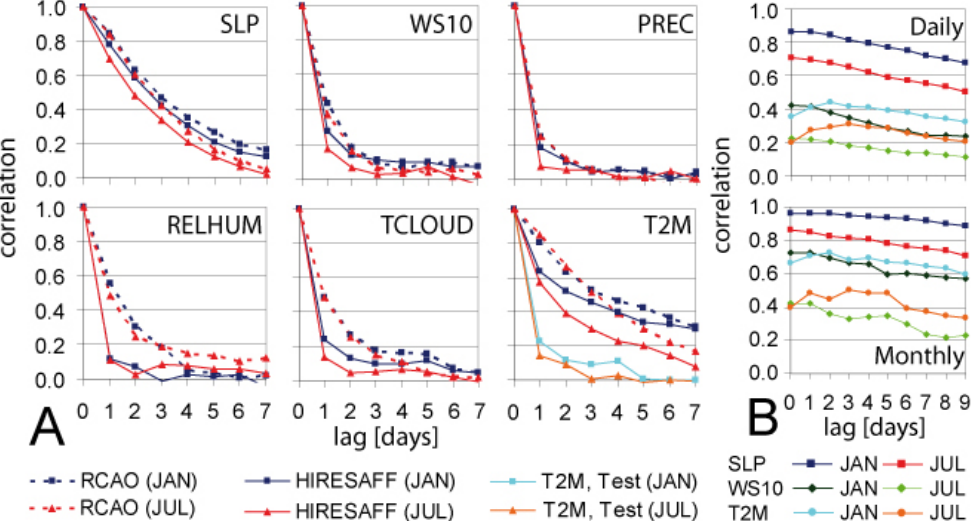
Fig. 10. Effect of implementing persistence in the analog-reconstruction. (A) Reconstructed daily auto-correlations of HiResAFF (solid lines) dependent on the used n-lag in the AM with RCAO and RCAX (shaded lines) for January and July at a grid point close to Stockholm. The test cases (light blue, orange) for T2M show the daily serial-correlation if T2M is reconstructed using the standard settings from Sect. 2.3.2. (B) Changes of daily (top) and monthly (bottom) mean field correlation between reconstruction and RCAO (RCAX) for different variables for January und July dependent on the used n-lag for the